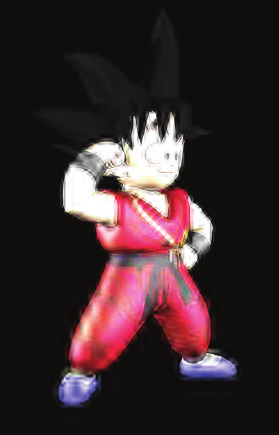
Figure 12: View of the Goku model corrupted by a loss in the fist part of the texture